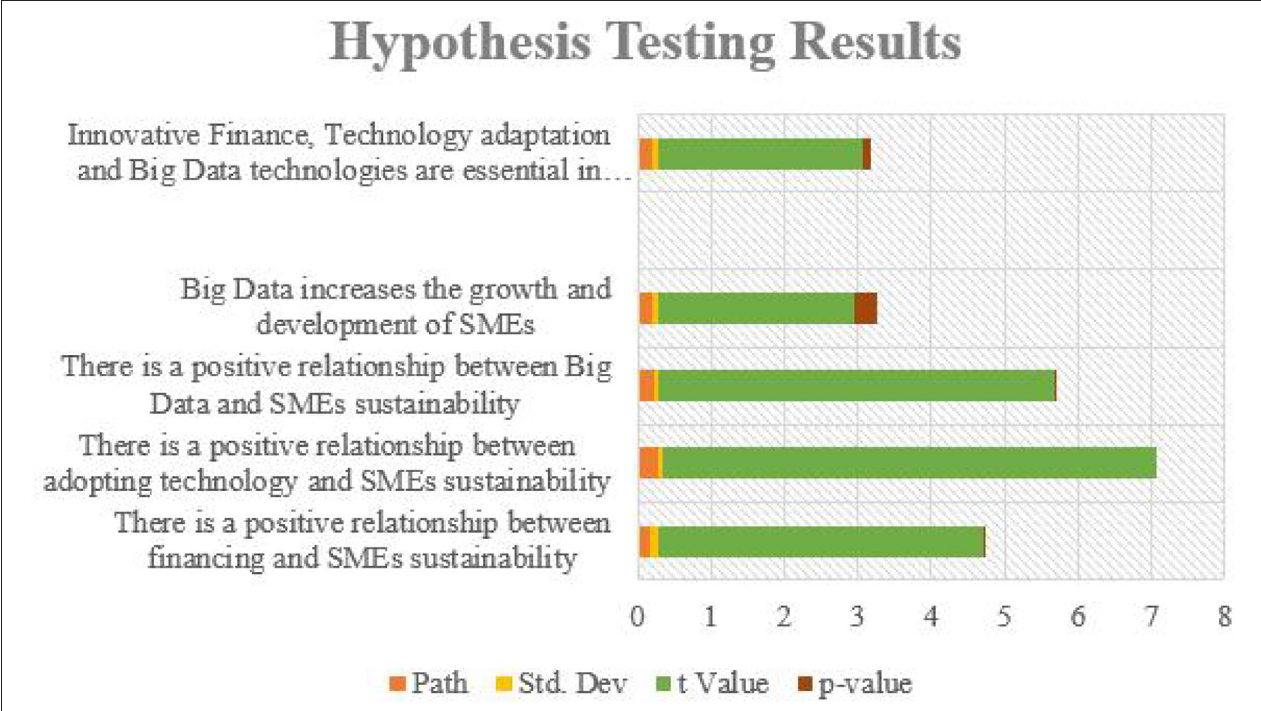
FIGURE 4 | Graphical representation of results of hypothesis